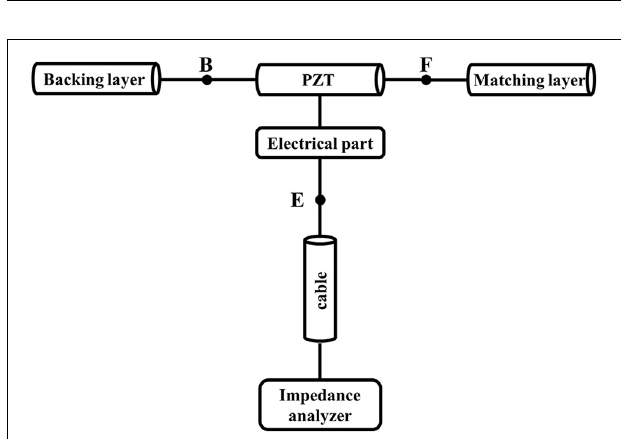
FIGURE 4 | The improved equivalent circuit simulation diagram of complete transducer.